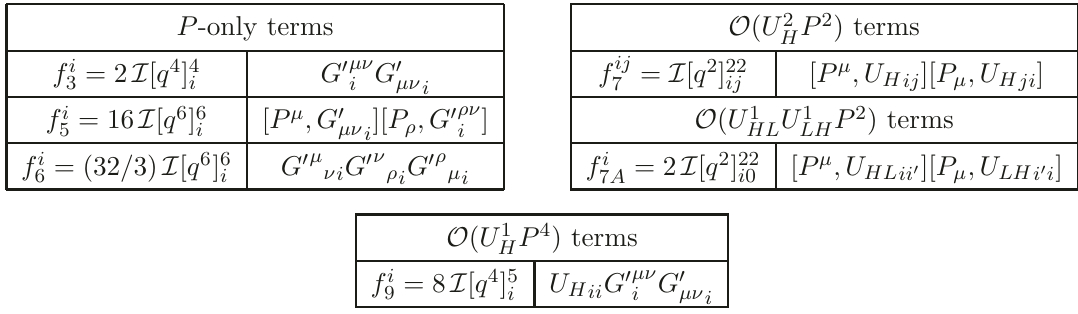
Table 1 . Left: universal coefficients f i heavy-heavy terms. Right: universal coefficients f ij terms, 1 heavy-heavy and 1 heavy-light. Centre: universal coefficient f i There is only 1 heavy-heavy